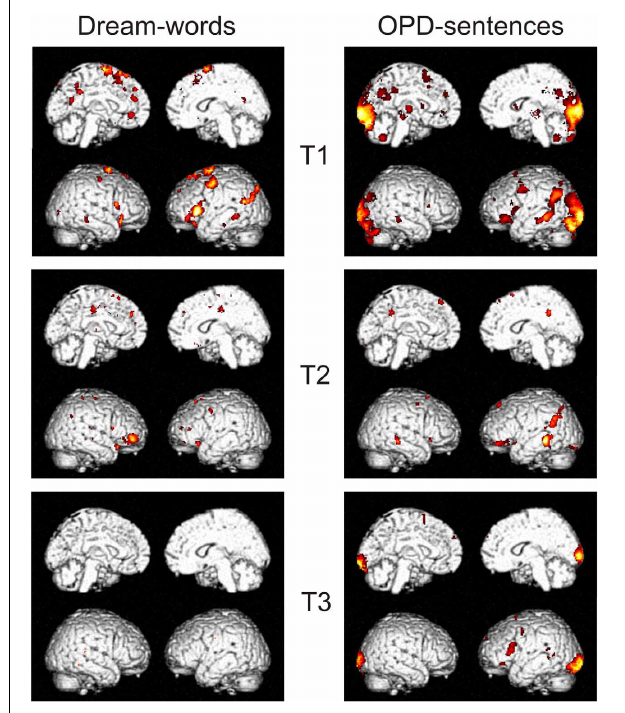
FIGURE 5 | T-contrasts Dream words > Neutral words (left side) and OPD-sentences > Relaxation (right) of a single subject (Subject Mrs A.) over time T1–T3, all thresholds to p < 0 . 05, T > 3 . 2, 10 voxels minimum, and corrected for multiple comparisons